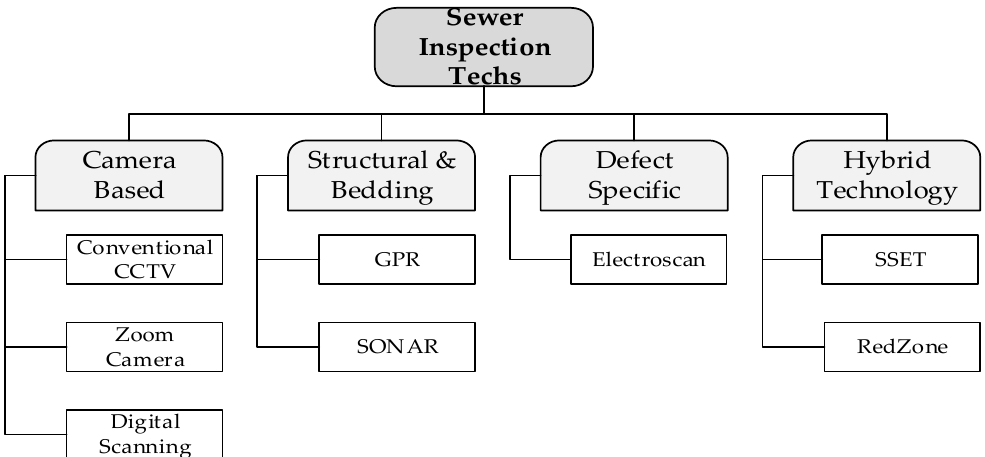
Figure 3. Different sewer pipeline inspection techniques.